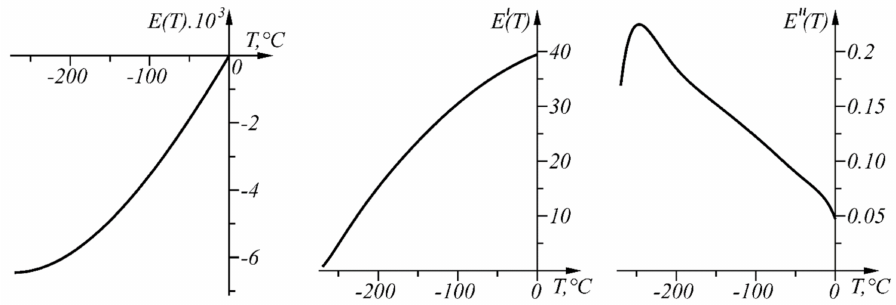
Figure 12. Graphs of the functions E ( T ) , E (cid:48) ( T ) , and E (cid:48)(cid:48) ( T ) in the range T ∈ [ − 270, 0 ] ◦